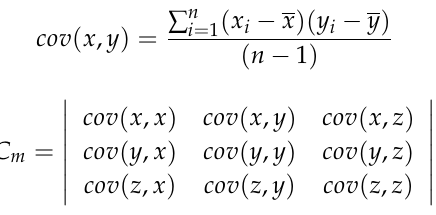
Figure 3. PCA eigenvector estimation.